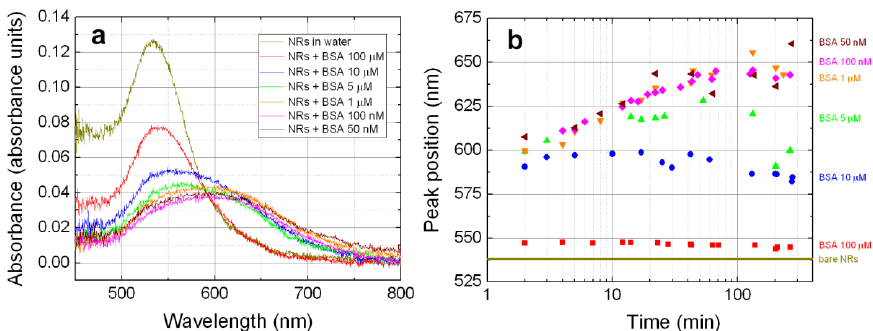
Figure 4. ( a ) Plasmon resonance of the CTAB-coated NRs diluted in water (gold line) and after few minutes from mixing with BSA in PB at different concentrations (other colored lines). ( b ) Position of the red-shifted component of the plasmon resonance of the BSA-NR complexes as a function of time for different BSA concentrations. In all fits, the position of the 540 nm peak (not shown) is constant within ±3%.